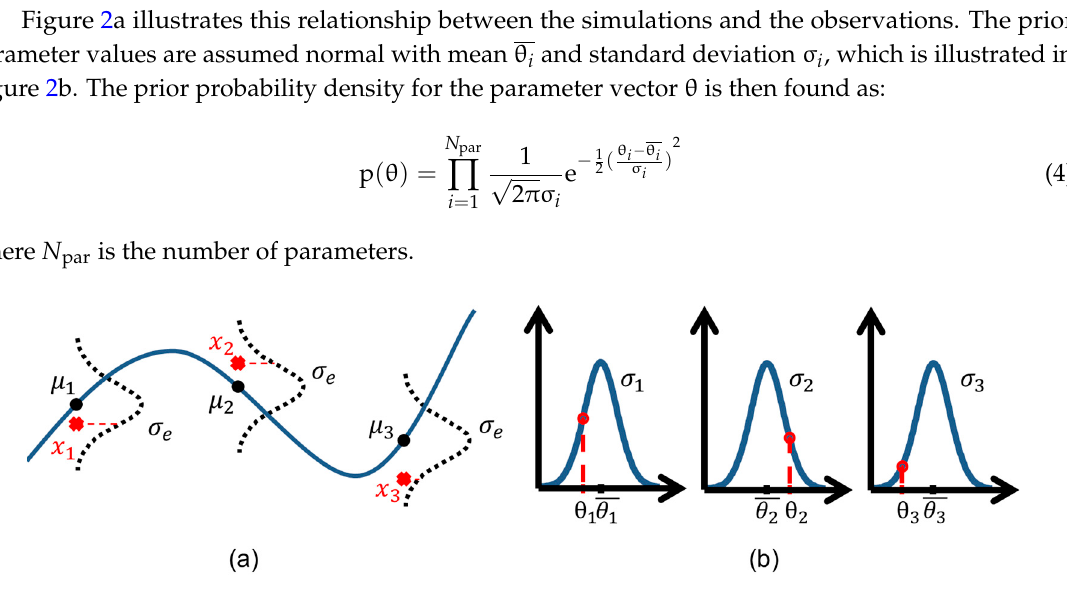
Figure 2. Depiction of Maximum a Posteriori estimation; ( a ) How likely the observations are to be an outcome of the model, p( x | θ ); ( b ) Total a priori parameter probability, p( θ ), for a model with three parameters.